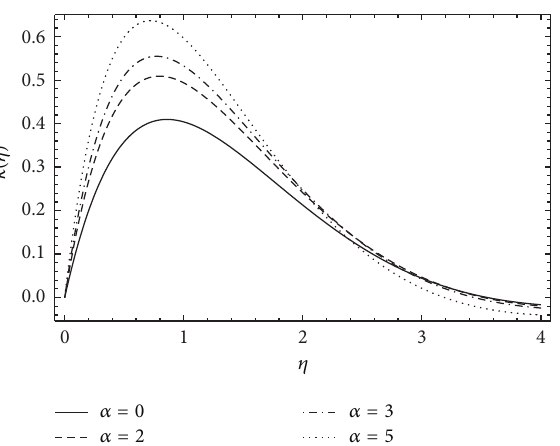
Figure 11: The influence of the couple stress parameter 𝜆 on ℎ(𝜂) for 𝛼 = 1 , ℏ = −0.1 , and 𝜆 = 0 (Newtonian case).